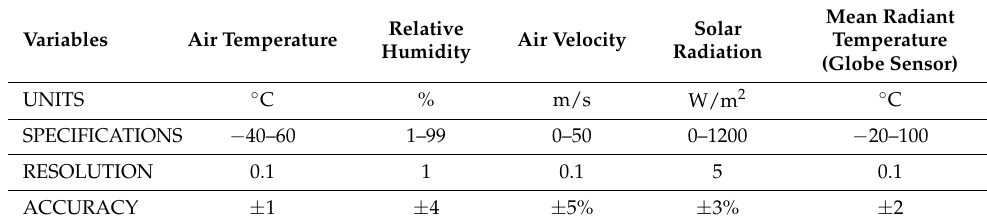
Figure 7. Temperatures are measured by the four fixed sensors put in the open-air space at the school entrance.